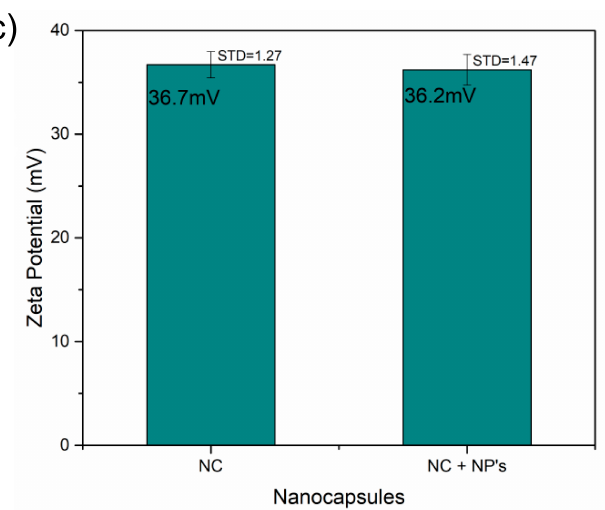
Figure 3. Zeta potential plots of the ( a ) emulsions, ( b ) the nanoparticle e ff ect on the emulsions and ( c ) the nanocapsules with and without the nanoparticles.